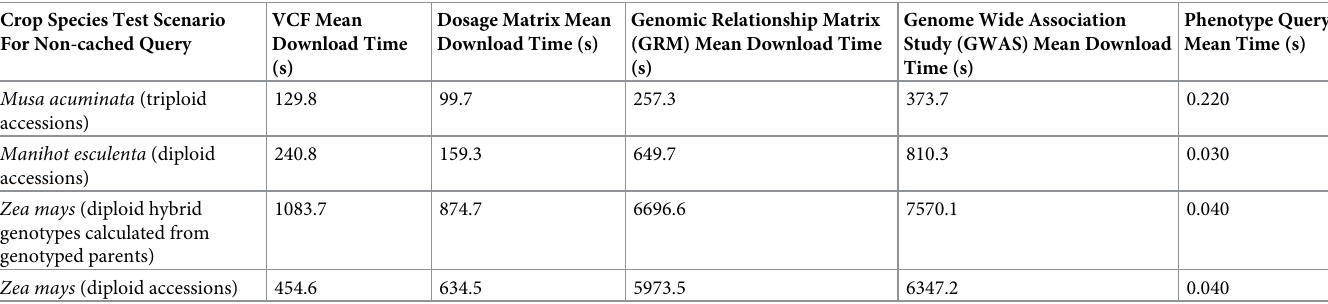
Table 3. Results for non-cached query performance.